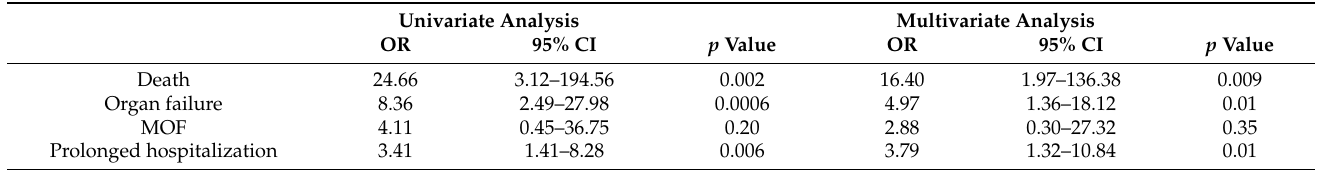
Table 5. The outcomes of CDI patients with mild/moderate versus severe/critical COVID-19. Univariate Analysis